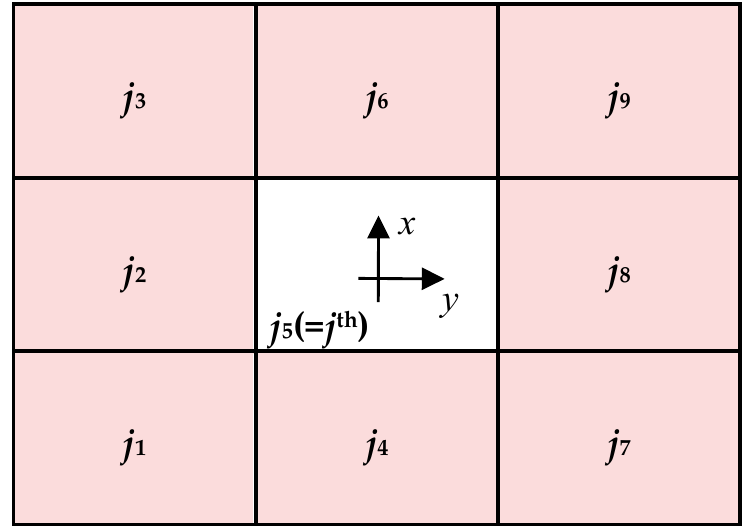
Figure 4. Neighboring panels of j th panel.